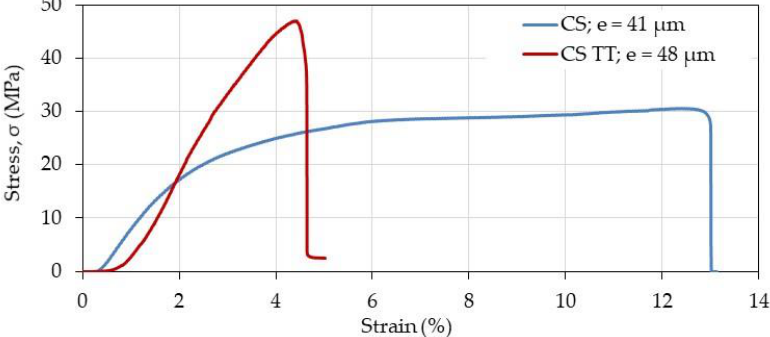
Figure 9. Effect of thermal treatment (TT) on mechanical chitosan film response in the dried state. The thickness (e) of the film samples was found around 40–50 μm.